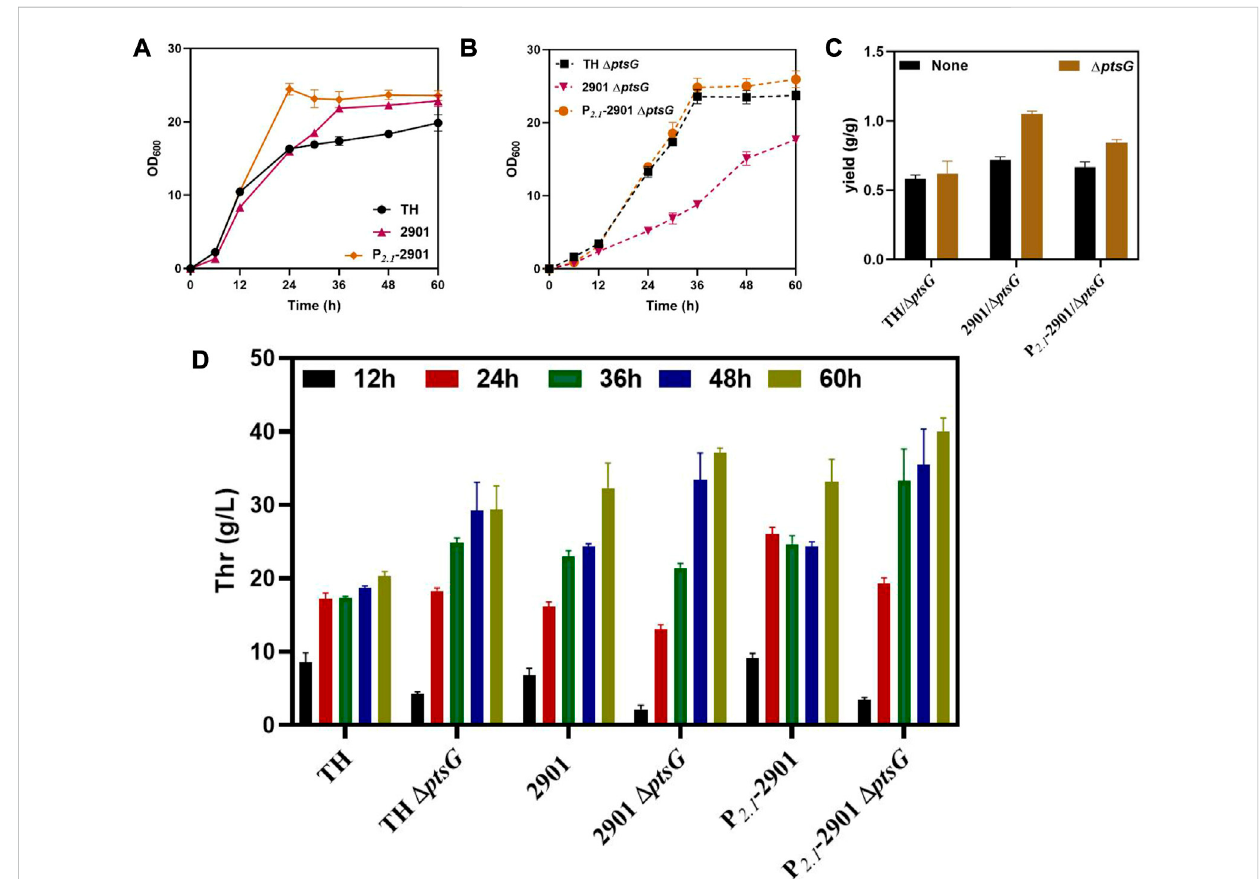
The effect of deleting ptsG on the growth and L-threonine production of strain TH. All results were determined from three ( n = 3) independent repeats. (A) Growthofstrainsbefore ptsG genedeletion. (B) Growthofstrainsafter ptsG genedeletion. (C) Theyieldofthe fi nalproductwascalculatedby the glucose consumption and L-threonine titer. (D) During fermentation, samples taken at 12, 24, 36, 48 and 60 h were used to measure L-threonine